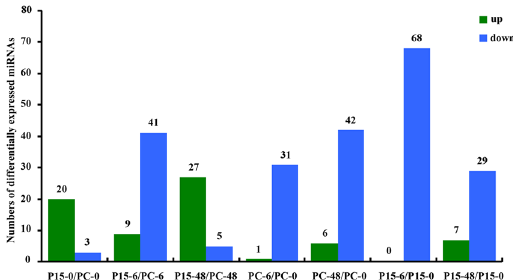
Figure 2. Contrast between up-regulated and down-regulated differentially expressed miRNAs in all comparisons. Differential expression analyses were run with the Bioconductor edgeR package with the condition that the ratio was greater than 2 and P < 0.05. Up represents the number of miRNAs that were up- regulated in the compared group, and down represents the number of miRNAs that were down-regulated in the compared